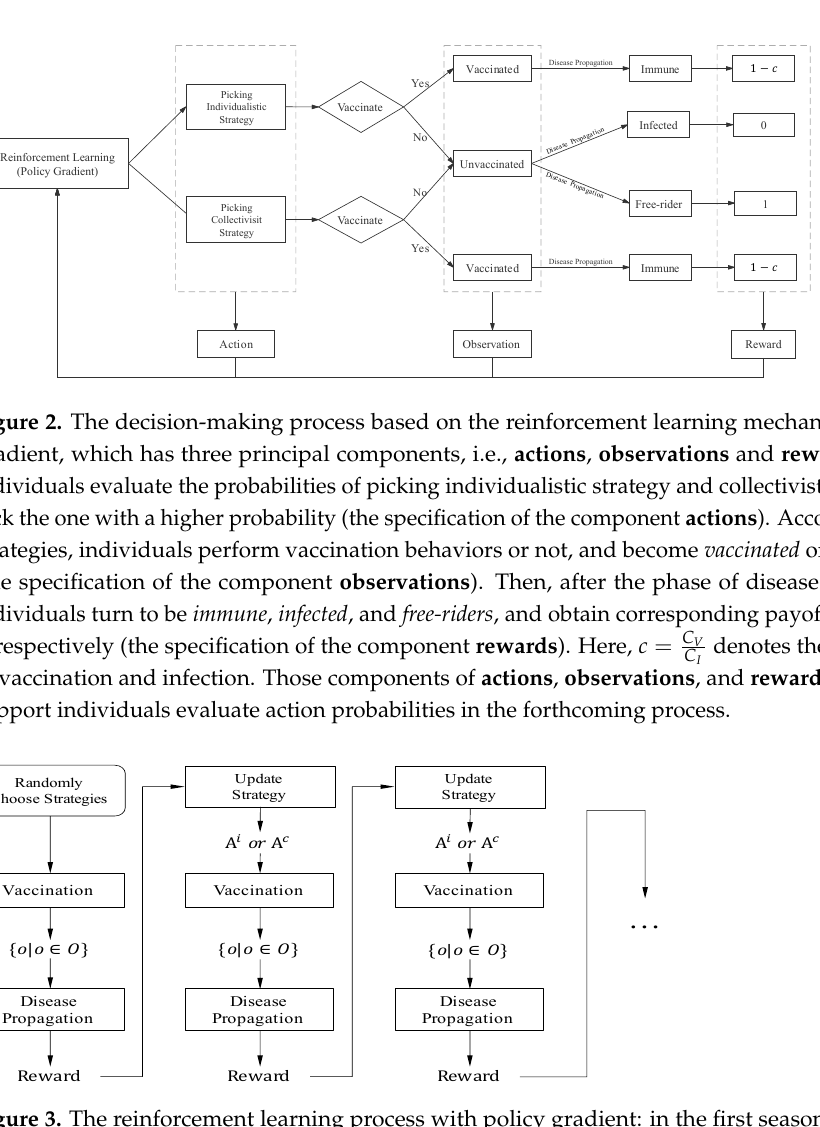
Figure 3. The reinforcement learning process with policy gradient: in the first season, individuals randomly choose vaccination strategies and enter vaccination and disease propagation to obtain the corresponding reward. Subsequently, they pick an optimal strategy according to previous choices and reward, and take or not take a vaccine for the next season of disease propagation. They repeat such operations until the process